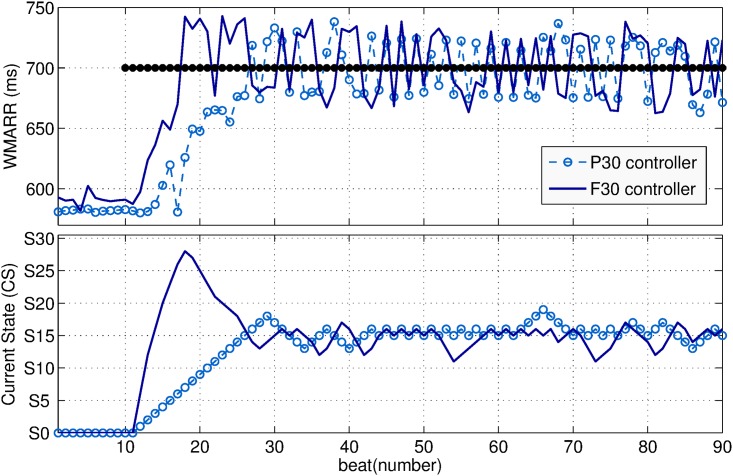
The top panel of the figure shows the WMARR response when the P30 (dotted line) and F30 (solid line) controllers are used to regulate RR to 700 ms. The bottom panel shows the dynamics of the P30 (dotted line) and F30 (solid line) controllers.